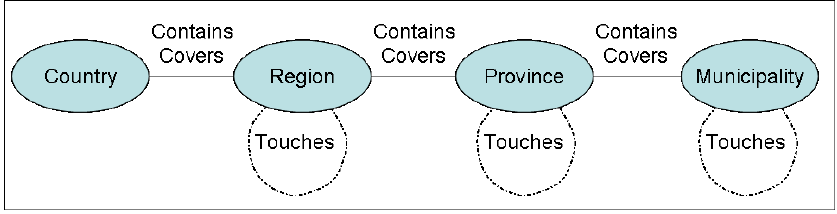
Figure 3. Example of ontology-based on spatial relations.